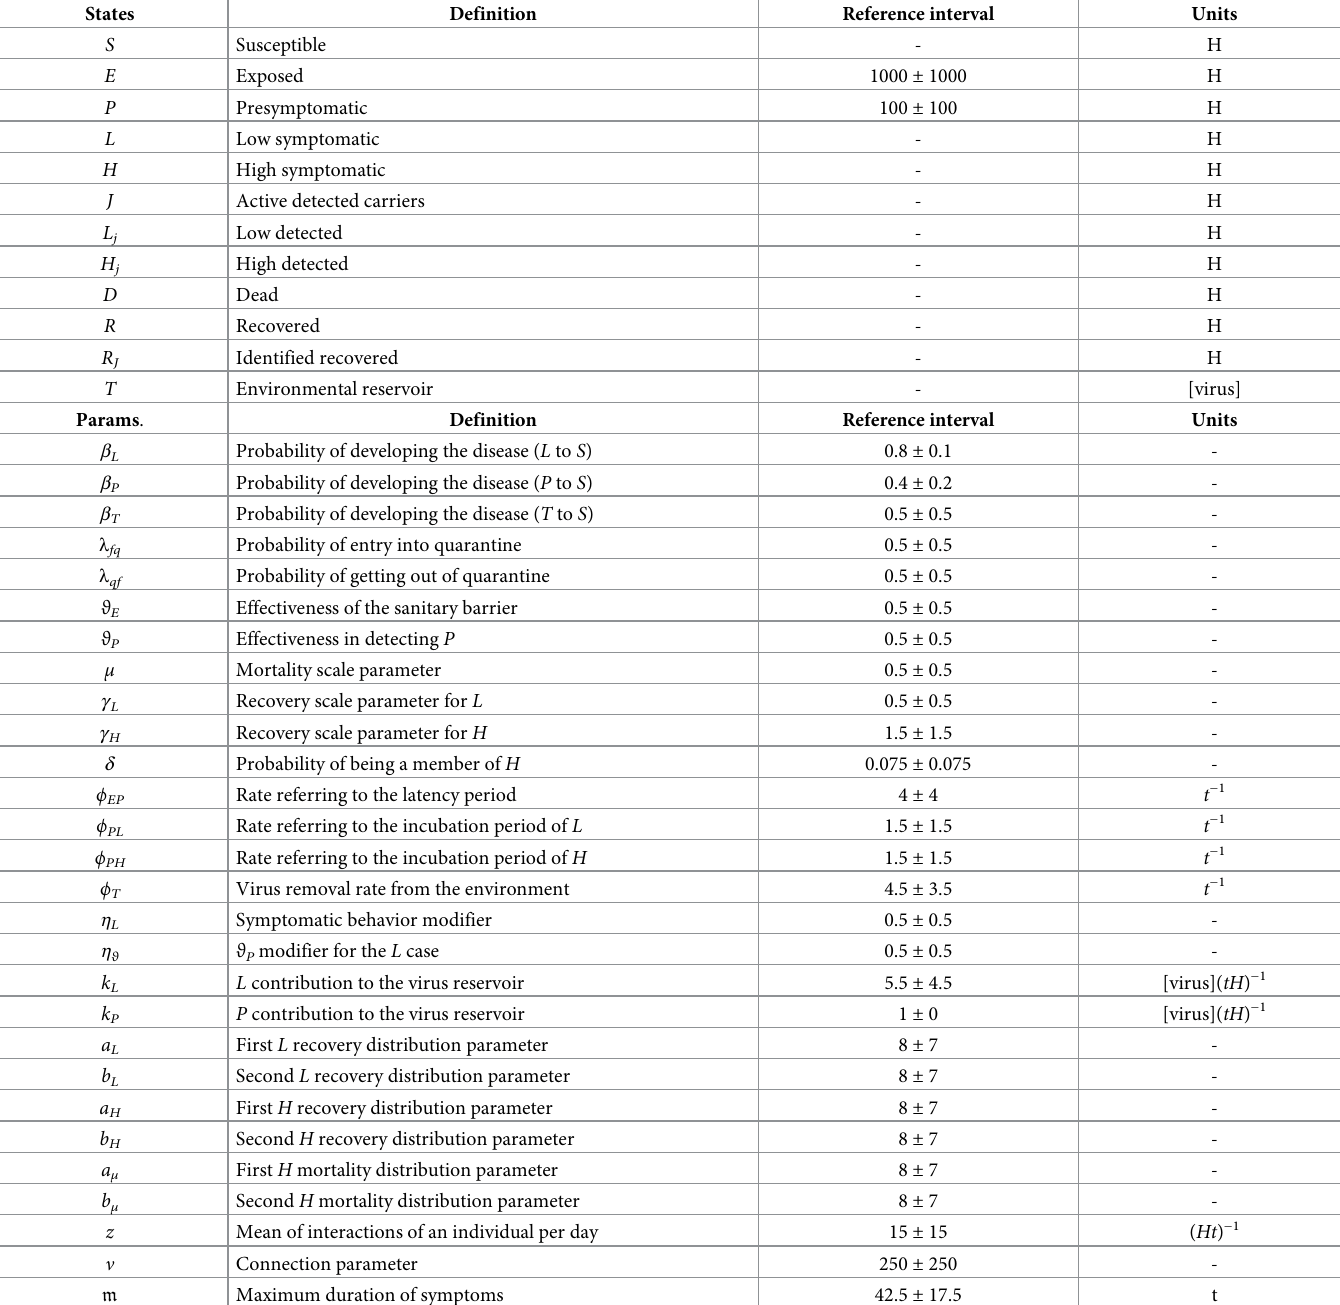
Table 1. Initial state and parameter definitions with their reference intervals. For further information about estimation intervals see [35–39].